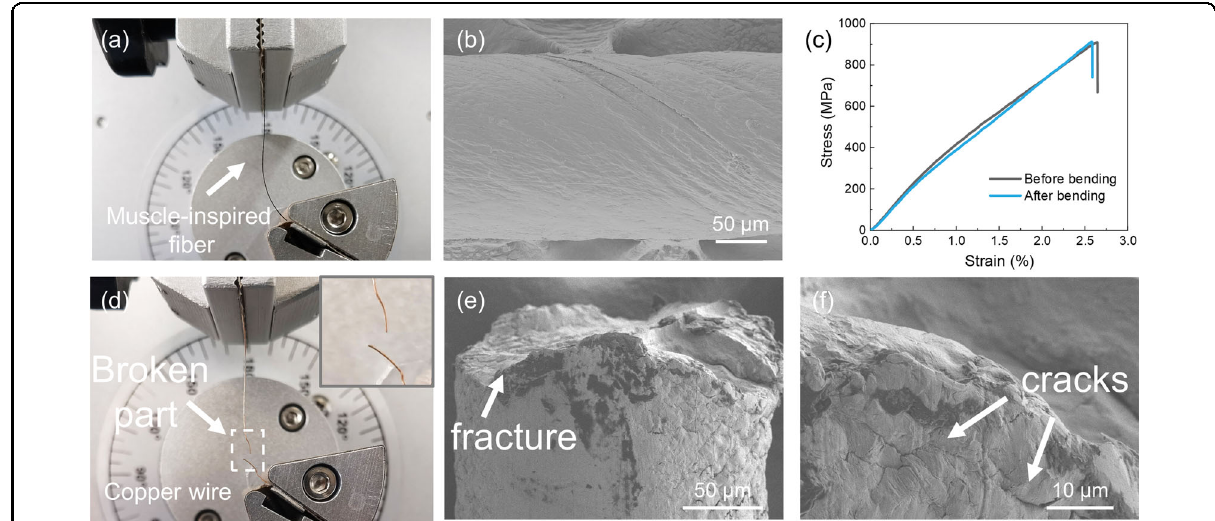
Fig. 4 The fatigue resistance of the muscle-inspired fi bers (15.9 wt% CNT). a Muscle-inspired fi bers in the bending test. b SEM image of the muscle-inspired fi bers with a diameter of ~190 μ m after the bending test. c Tensile stress – strain curves of the muscle-inspired fi bers before and after 100,000 cycles of the bending test. d A common conductive copper wire breaks after 400 cycles of the bending test. The inset photograph is an enlarged view of the broken part. e SEM image of the broken part of the copper wire with a diameter of ~200 μ m, showing a relatively smooth fracture surface. f SEM image of the area around the fracture, showing the cracks from repeated